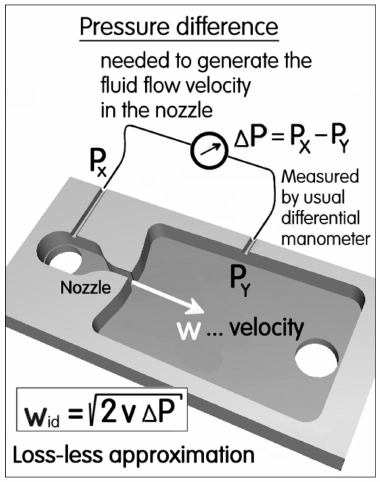
Figure 17. Typical dependence between pressure di ff erence across the nozzle and the exit velocity in a planar fluidic device. The delays in the version in Figure 15 are inversely proportional to the flow velocity w, which, in turn, increases (here for simplicity neglecting friction losses) with the square root of the acting pressure di ff erence ∆ P. Adapted from